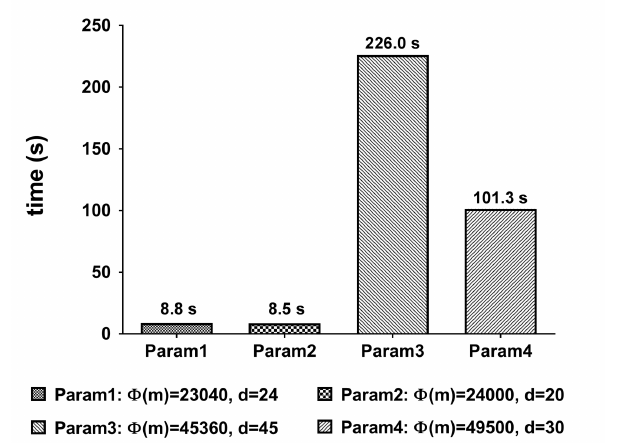
Figure 13. Execution time of the trace